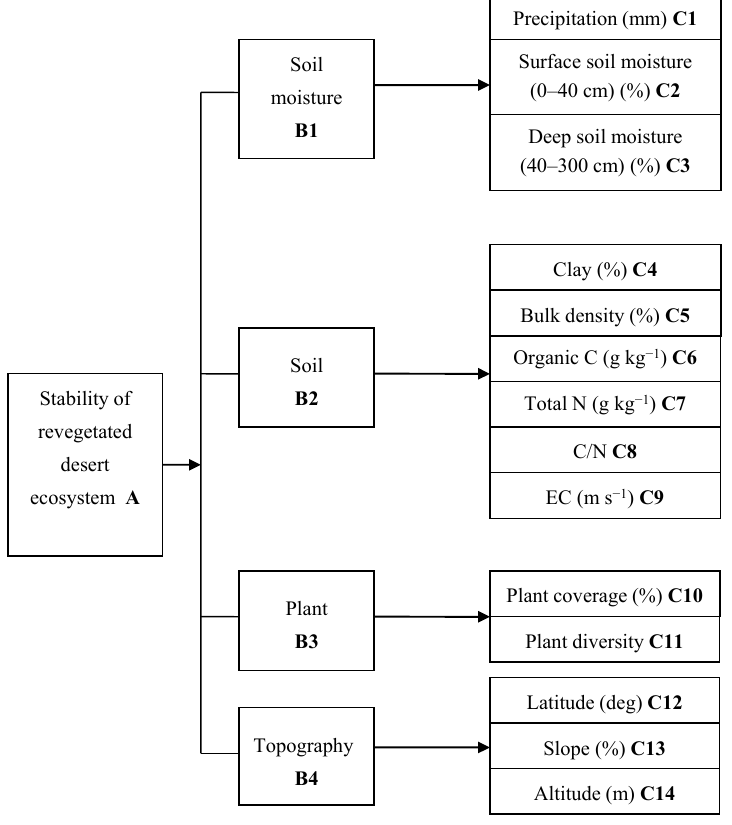
Figure 2. A hierarchy for the stability evaluation of revegetated desert